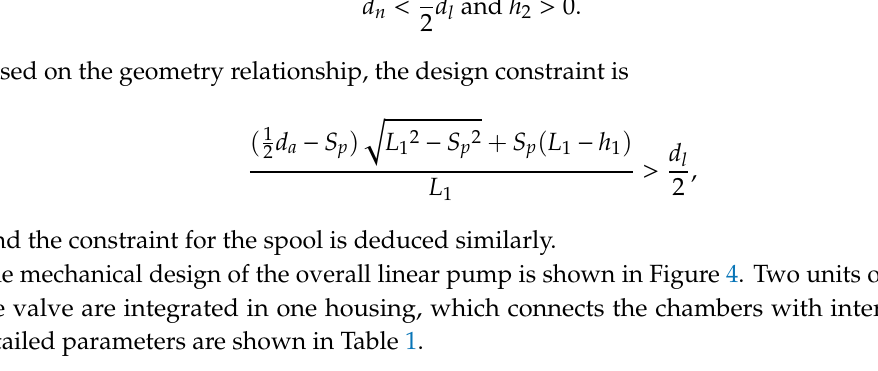
Table 1. Mechanical parameters of the pump.